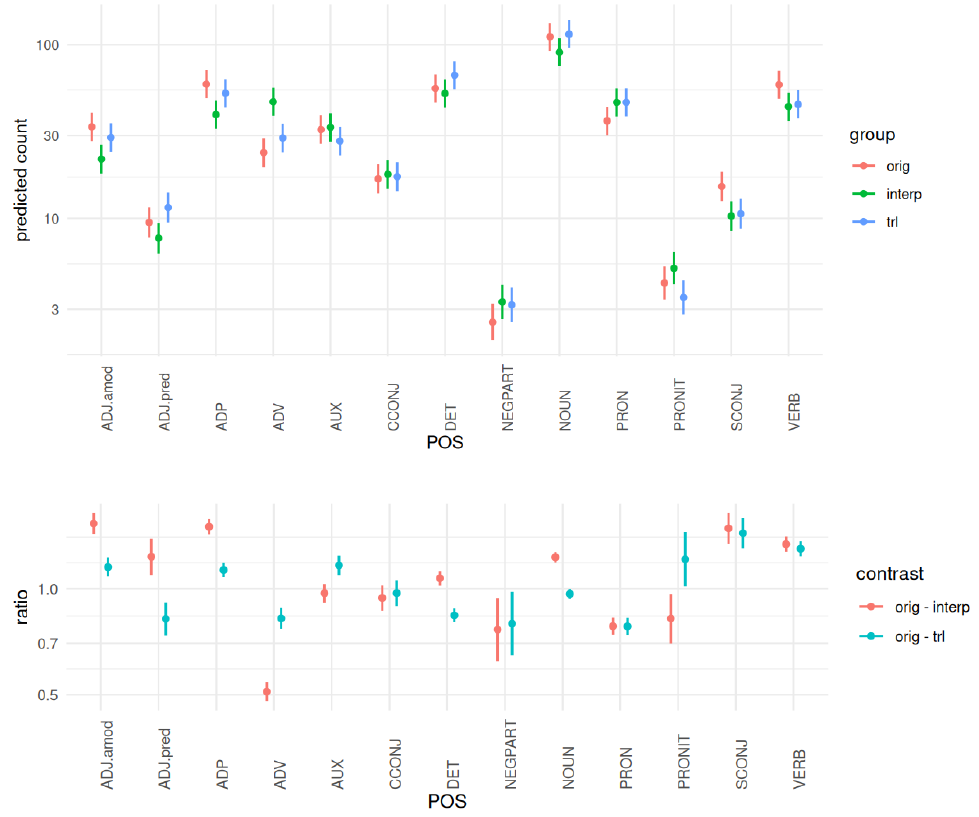
Figure 4. Top: predicted frequencies (log-transformed) for text of average length (564.5 words), with 95% confidence intervals; bottom: pairwise post hoc comparisons, indicating the ratios of tags, with 95% confidence